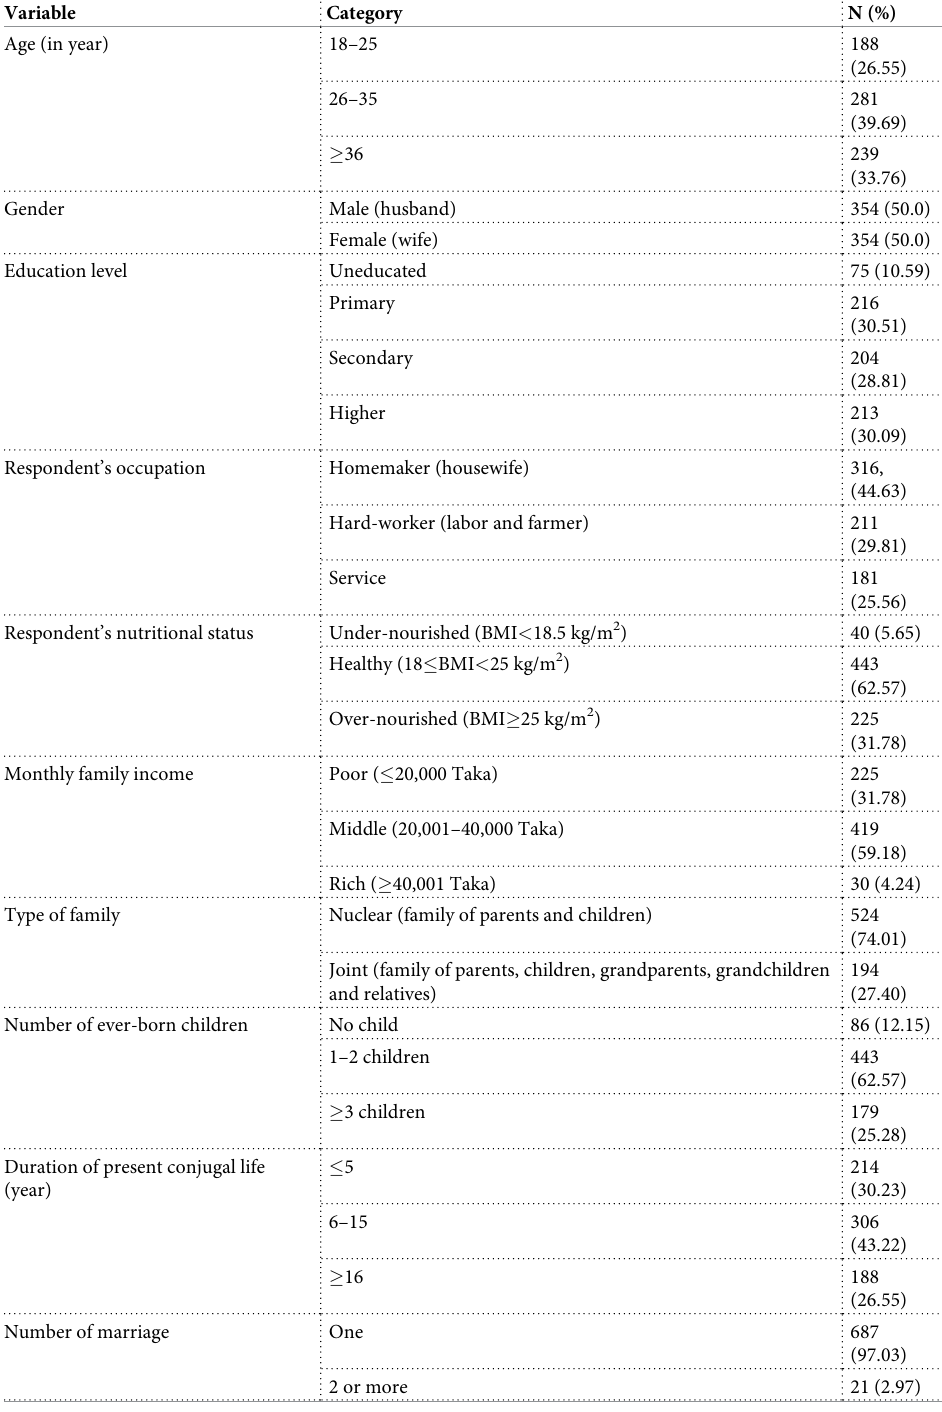
Table 1. Selected independent variables with their categories, definition, codes and frequency